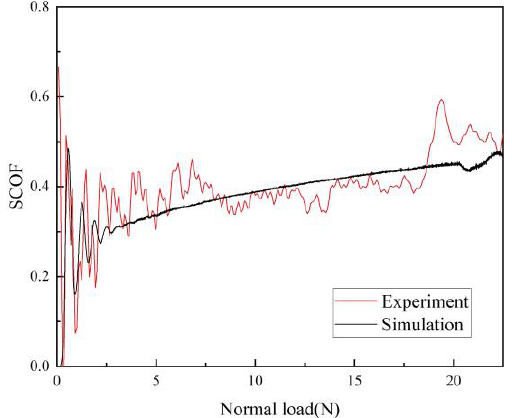
Figure 6. Scratch coefficient of friction (SCOF) as a function of normal load obtained experimentally and numerically.